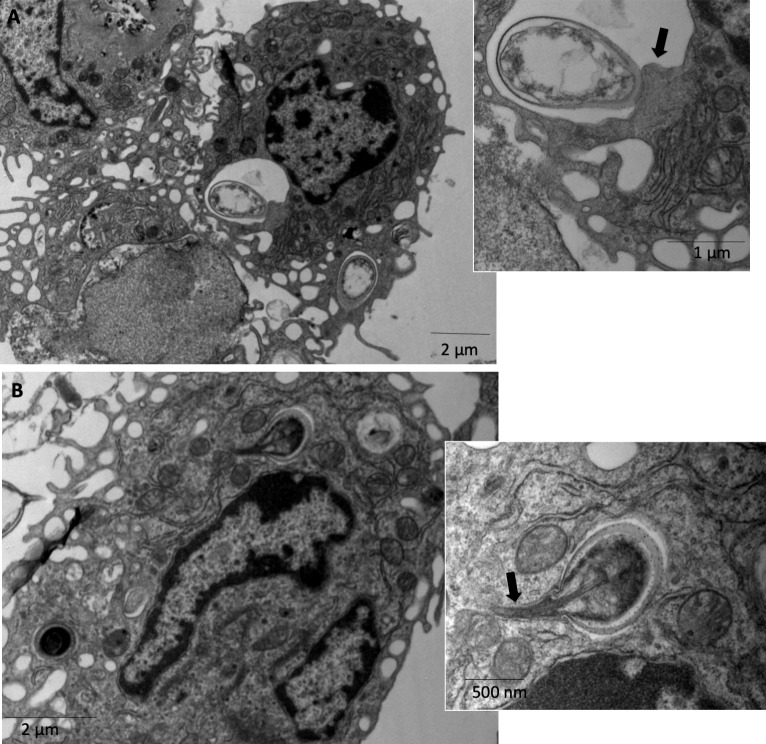
Relations between phagocytes from XID APerC and phagocytized E. cuniculi spores after 1 h of infection by ultramicrography.(A) Contact area between the phagocytic vacuole membrane of the macrophages and the internalized spore wall (arrow). (B) Germinated spore with extruded polar tube (arrow) from the phagosome vacuole.